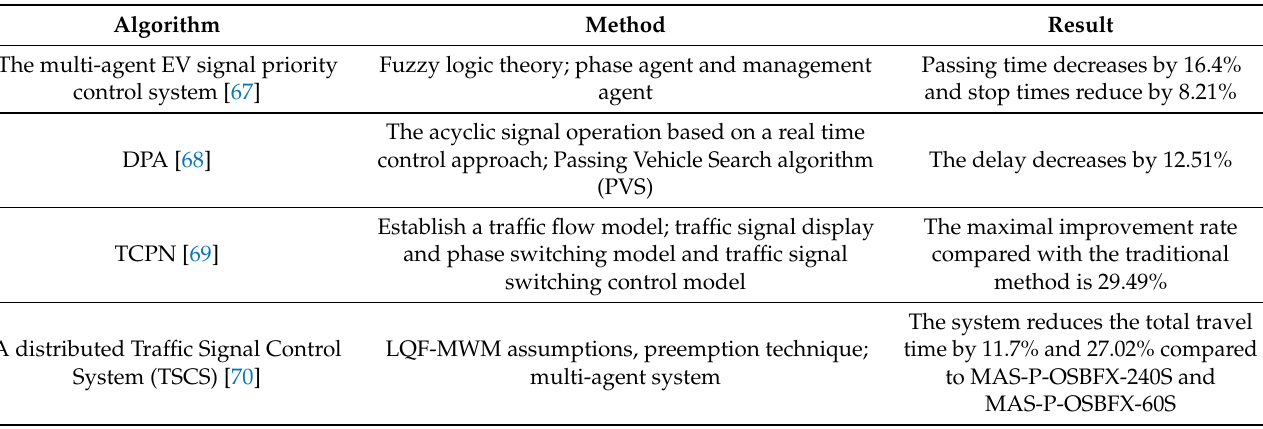
Table 7. Algorithms comparison of emergency vehicle